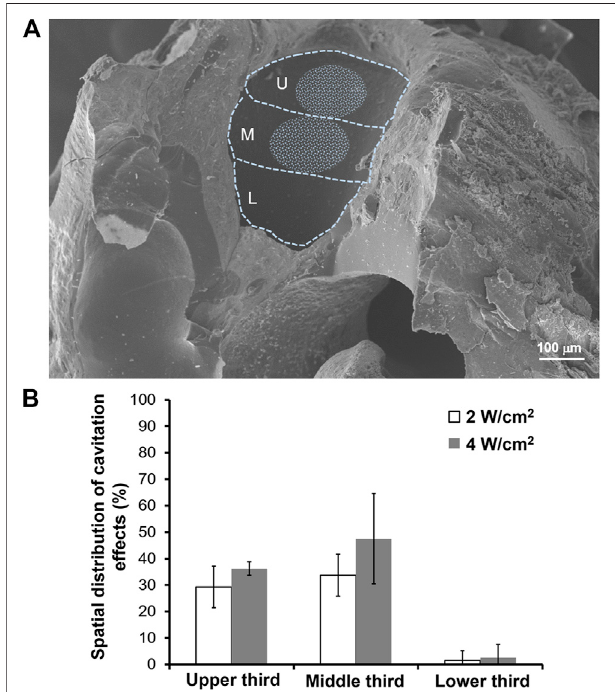
FIGURE7| CavitationeffectsareaoftheRWMfollowingUSMBtreatment. (A) A representative SEM image of the left side of the RWM was divided into upper, middle, and lower third parts. The whitish circled area indicates the area where USMBs reacted at an acoustic intensity of 2 W/cm 2 . (B) Comparisonoftheproportionofthereactionareaatacousticintensitiesof2and 4 W/cm 2 . U (cid:2) upper third; M (cid:2) middle third; L (cid:2) lower third. The results are expressedasthemean ± standarderrorofthemean,with n (cid:2) 10foreachbarin the 2 W/cm 2 group and n (cid:2) 4 in the 4 W/cm 2 group.